Question: Looking at the figure, what chart type is it?
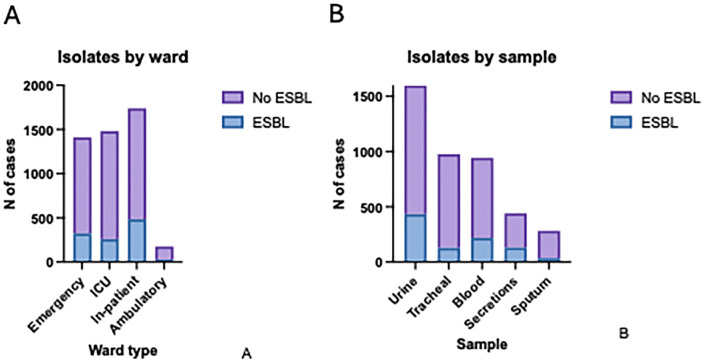
Answer: bar